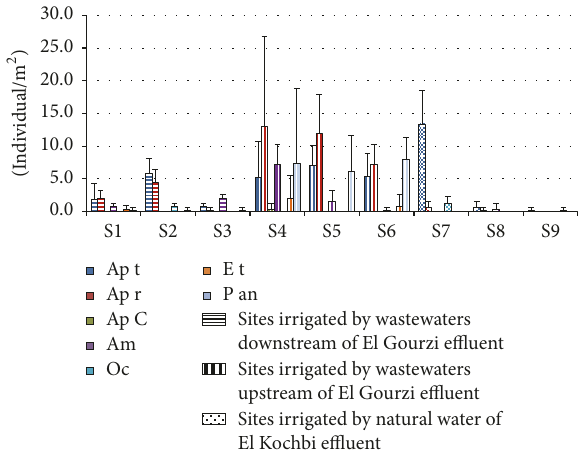
Figure 9: Earthworms’ specific abundance average in study sites.